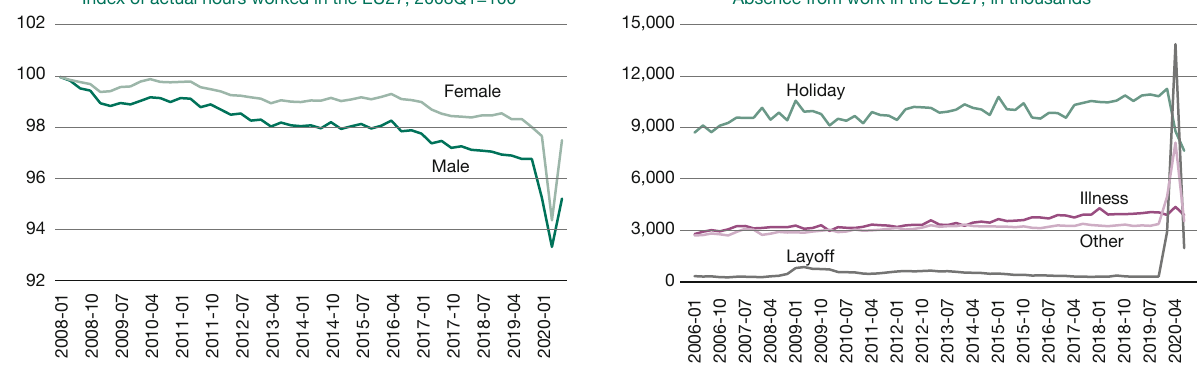
Note: The index represents quarterly changes in the actual hours worked in the main job for full time workers. It indicates the percentage of change in the total actual hours of work in the considered quarter of a year compared to the total actual working hours in 2008. Source: Authors’ own elaboration based on Eurostat.